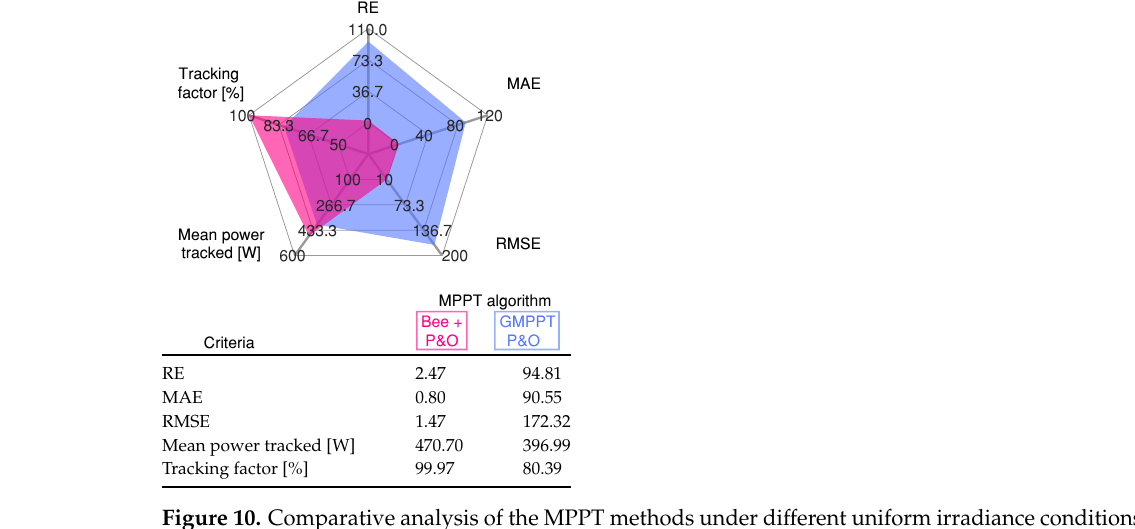
Figure 10. Comparative analysis of the MPPT methods under different uniform irradiance conditions for Scenario 2 shown in Figure 9.